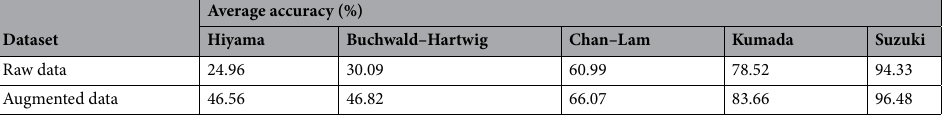
Table 2. Average accuracy comparison of several coupling reactions between raw data and augmented data based on the transformer-baseline model.